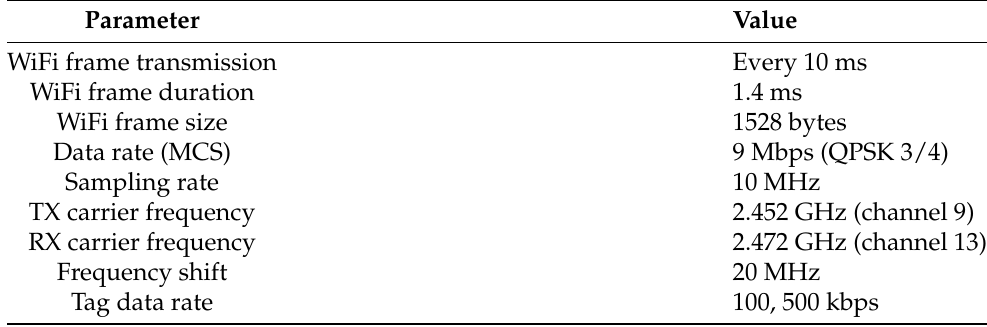
Table 1. Experimental parameters.